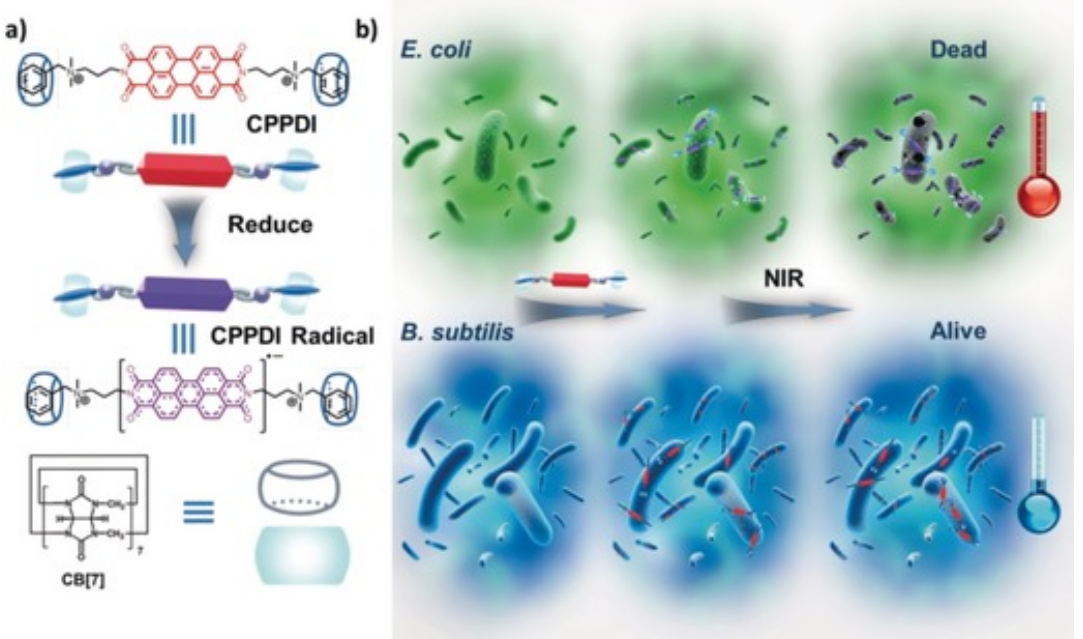
Figure 11. ( a ) Chemical structures of the supramolecular complex (CPPDI) and CPPDI radical anions. ( b ) Diagram of photothermal therapy for supramolecular complex with high selectivity towards E. coli over B. subtilis . Reprinted with permission from Ref. [104]. Copyright 2017 Wiley-VCH.